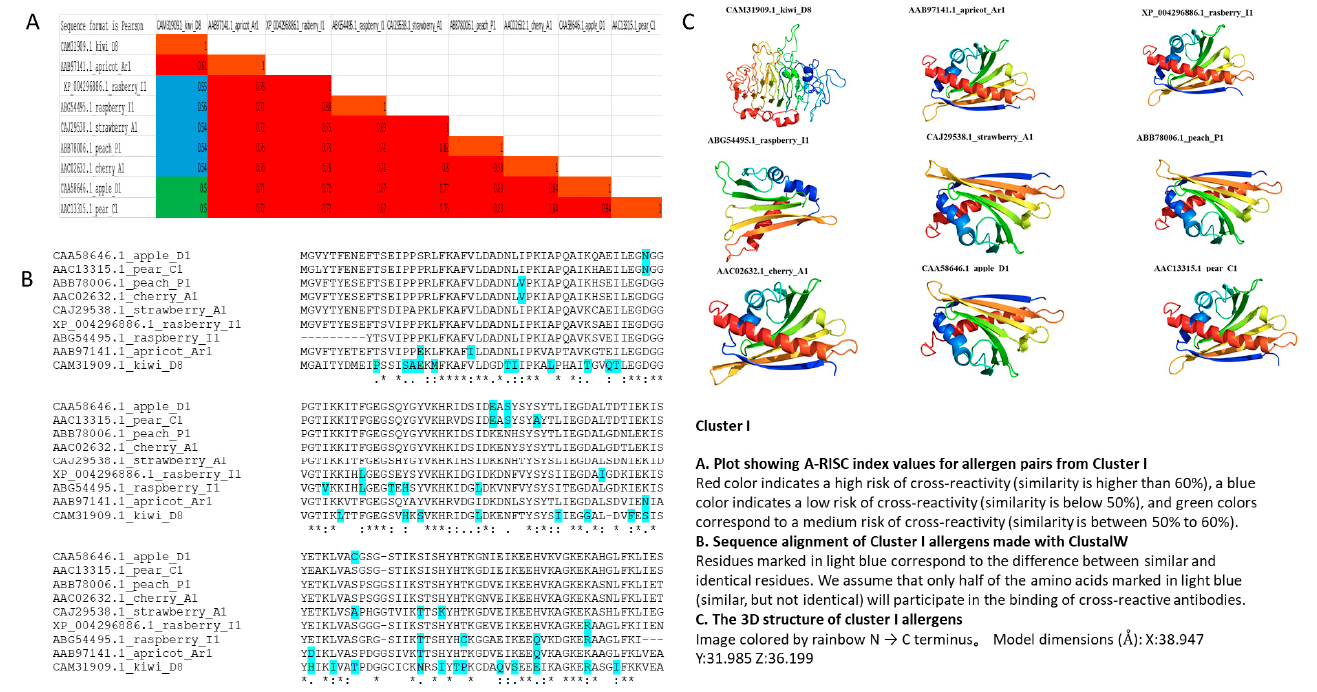
Figure 2. A-RISC index values, sequence alignment, and 3D structure of Cluster